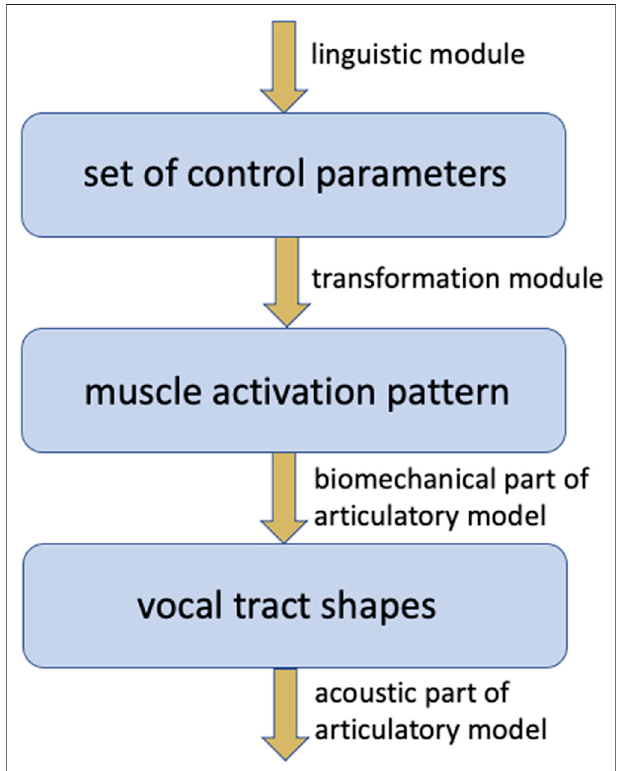
FIGURE 3 | Hierarchical organization of articulatory models and their control modules and their levels of control (blue boxes).